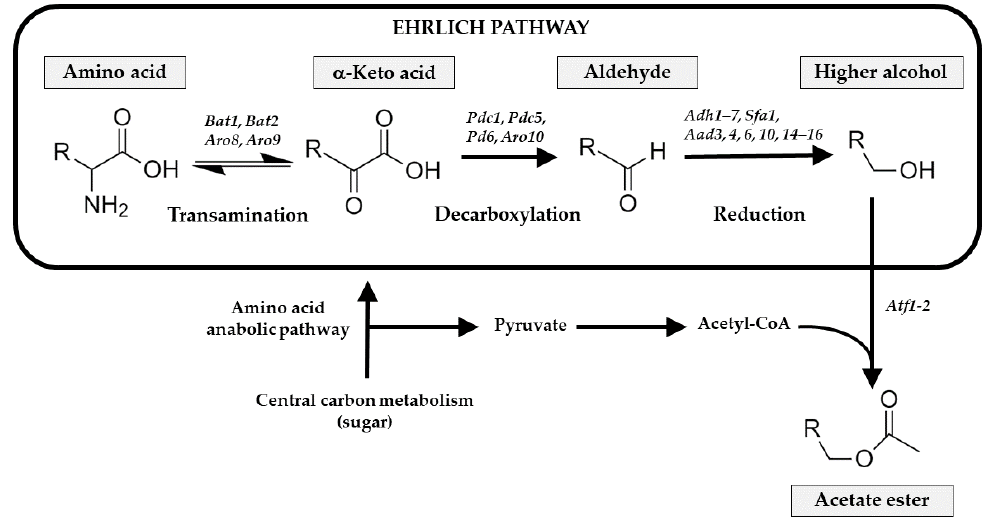
Figure 3. Ehrlich pathway (square) in Saccharomyces cerevisiae, biochemistry and main genes encoding enzymes (italics) involved in this catabolic pathway. It consists of three stages in which higher alcohols are produced from assimilated amino acids. In the first step, amino acids are deaminated in a reversible transamination reaction to the corresponding α -keto acids, followed by a decarboxylation in the second step of α -keto acids to aldehydes. In the third step, the reduction of aldehydes to the corresponding alcohol by alcohol dehydrogenases catalyzes this last step of the Ehrlich pathway. The higher alcohols can be esterified to produce the equivalent acetate esters once they have been synthesized. The biosynthesis of amino acids from a carbon source, or the anabolic pathway, may also provide the α -keto acid.